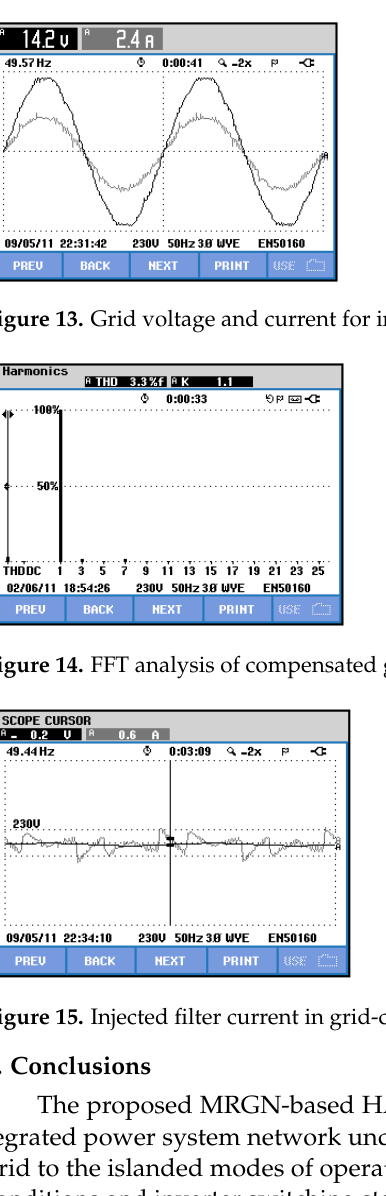
Figure 12. FFT analysis of distorted grid current with inductive load and without any filtering ac- tion.